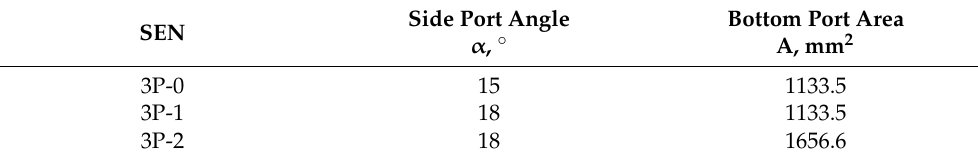
Figure 2. Schematic of typical SENs investigated. Table 1. Parameters of SEN structure. Table 1. Parameters of SEN structure.